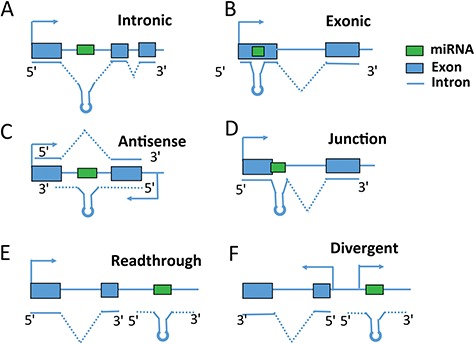
Intragenic miRNA classification. miRNA categories are defined based on their locations relative to exon, intron and gene regions.